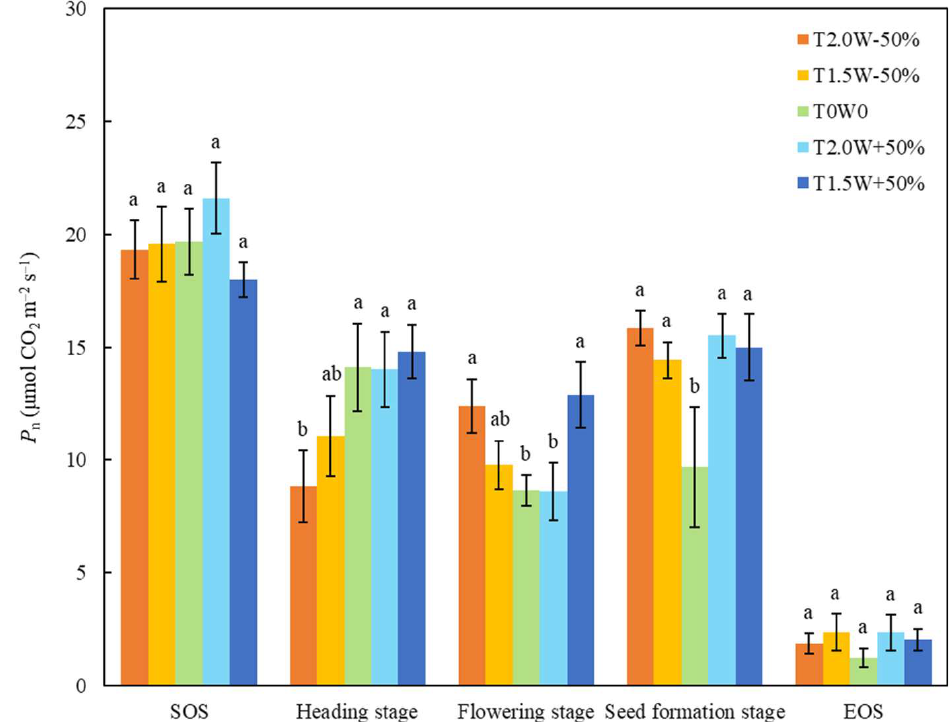
Figure 2. Effects of temperature and precipitation treatments on the net CO 2 assimilation rate ( P n ) at different stages (means ± SE). Different lowercase letters were used to indicate significant differences among treatments ( p < 0.05).